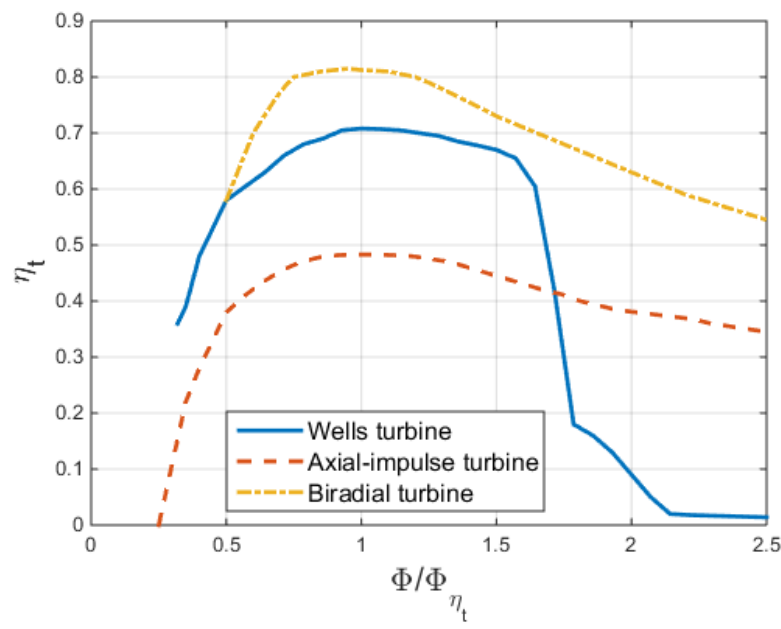
Figure 5. The efficiency of Wells turbines, axial-impulse turbines and biradial turbines ploted against the flow coefficient ratio Φ / Φ η and